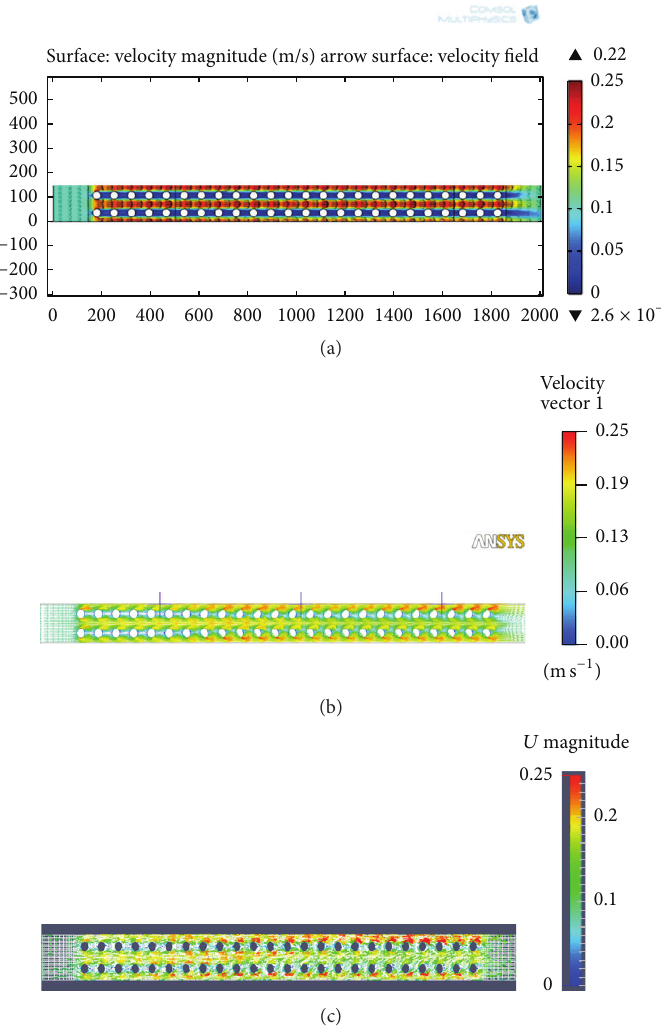
Figure 10: Velocity fields from the computation with various codes, Case 3: (a) COMSOL (2D), (b) ANSYS-CFX (3D), and (c) OpenFOAM